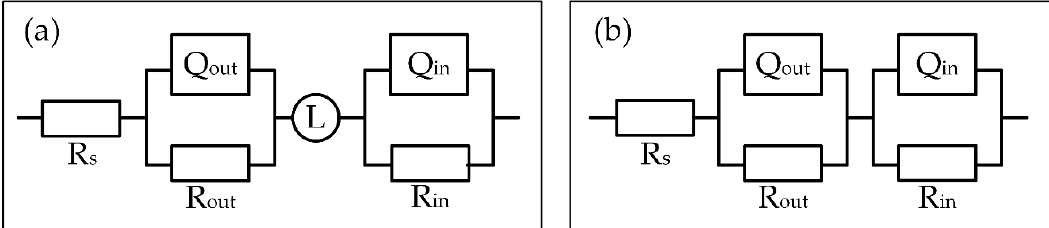
Figure 3. The electrical equivalent circuit diagram of passive film: ( a ) for A508-3; and ( b ) for 304L and In800.